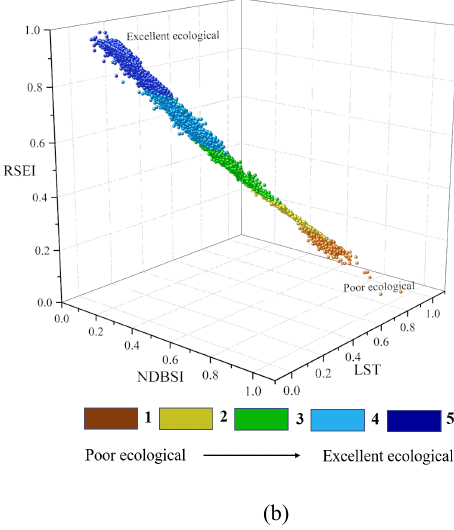
Fig.5 . 3D scatterplots of RSEI and NDVI, WET, LST, and NDBSI indicators in